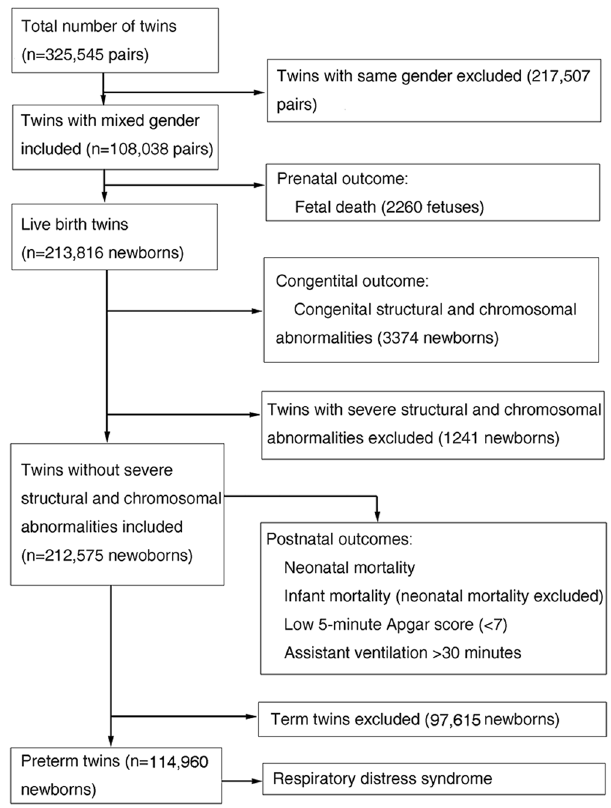
Figure 1. Flow diagram. The U.S. National Center for Health Statistics Linked Birth-Infant Death Cohort, Detail Matched Multiple Birth datasets from